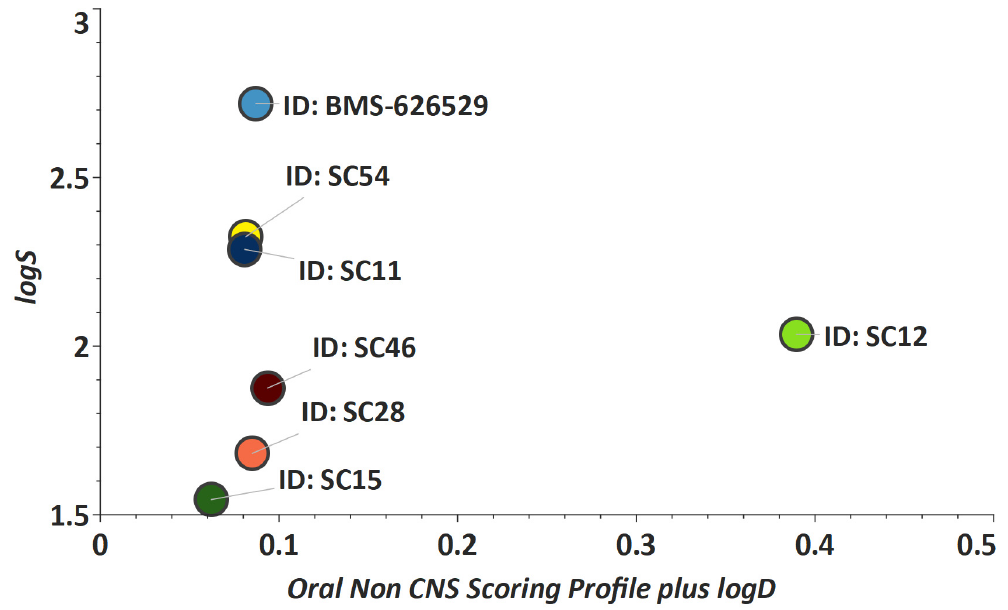
Figure 3. Plot showing the StarDrop 6.6 (Optibrium, Ltd., Cambridge, UK)-derived logS versus the score from a multimetric oral non-CNS profile for the BMS and SC compounds used in this study.